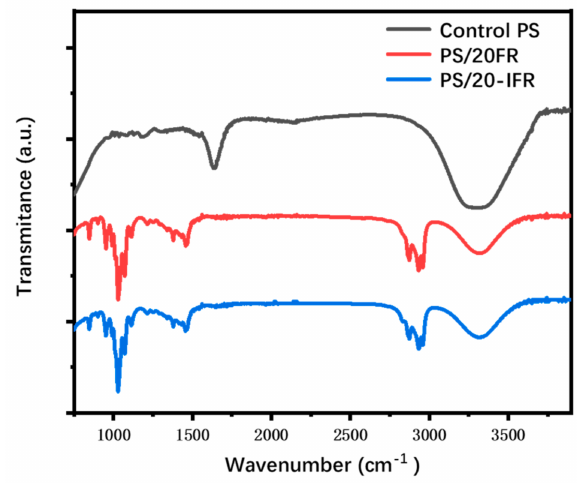
Figure 2. FT-IR spectra of control PS, PS/20%IFR, and PS/20%N-IFR.